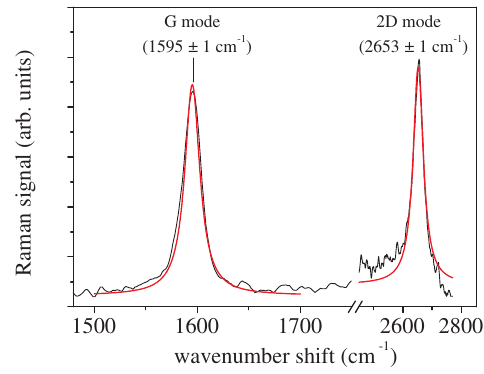
Figure 1. Raman spectrum of pristine graphene. The two main Raman modes (G and 2D modes) have been fitted by Lorentzian functions (red lines) centered at 1595 ± 1 cm − 1 and at 2653 ± 1 cm − 1 ,